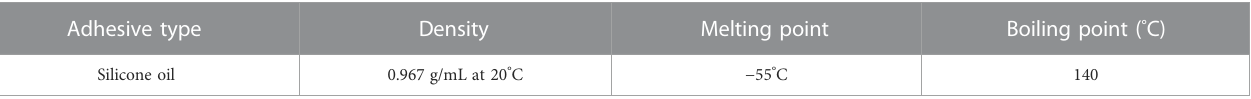
TABLE 1 Characteristic of adhesive.